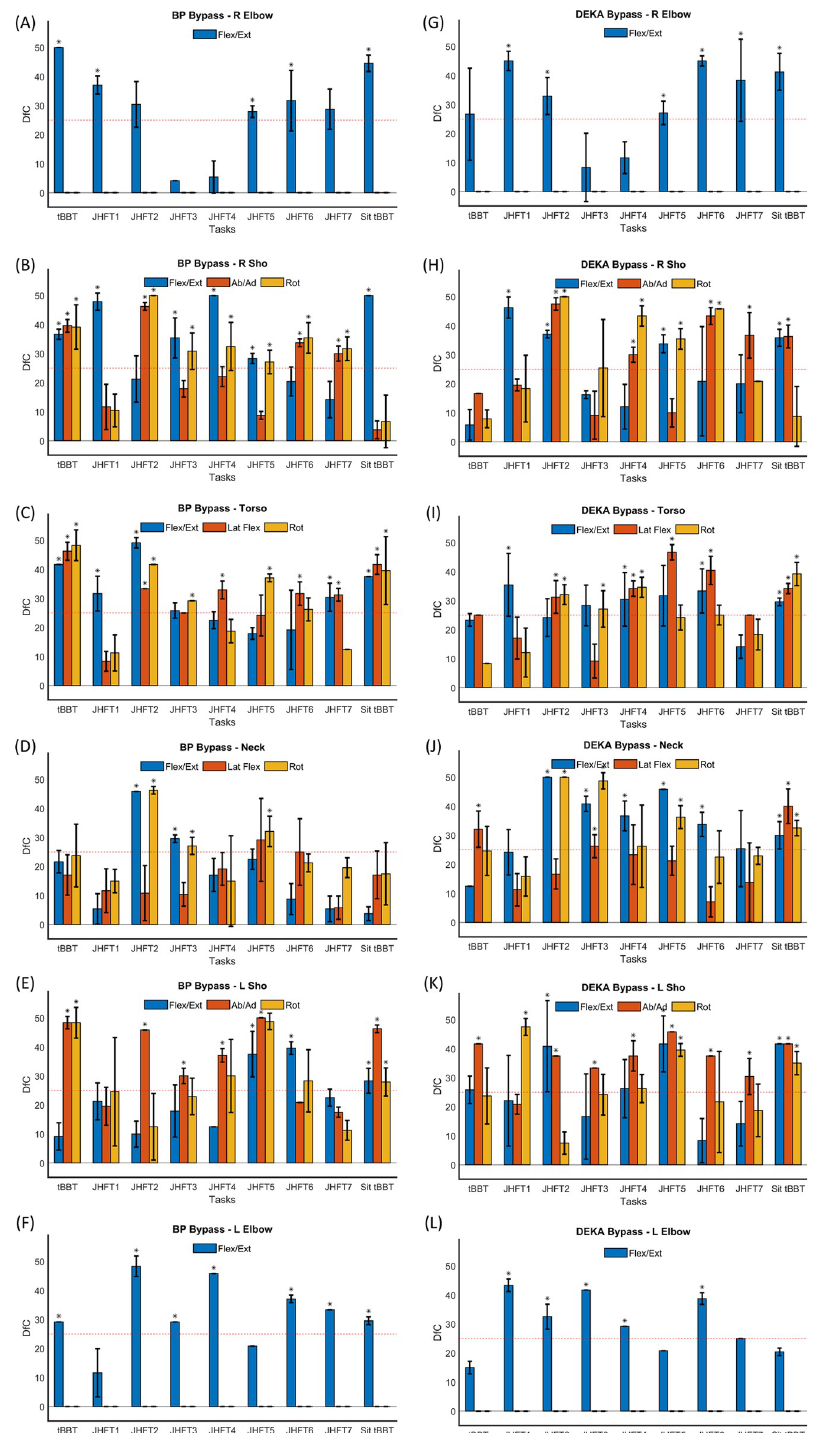
Fig 3. Average and standard deviation from chance (DfC) for all tasks, DOFs, and bypass condition comparisons: A-F) Body Powered Bypass v. Norm Joint results, G-L) DK Bypass v. Norm Joint Results. Tasks: JHFT1—Writing, JHFT2—Page Turning, JHFT3—Picking Up Small Objects, JHFT4—Simulated Feeding, JHFT5—Stacking Checkers, JHFT6—Moving Large Light Objects and JHFT7—Moving Large Heavy Objects. Distributions significantly greater than the threshold at DfC = 25 (red dotted line) denoted by a � (p <